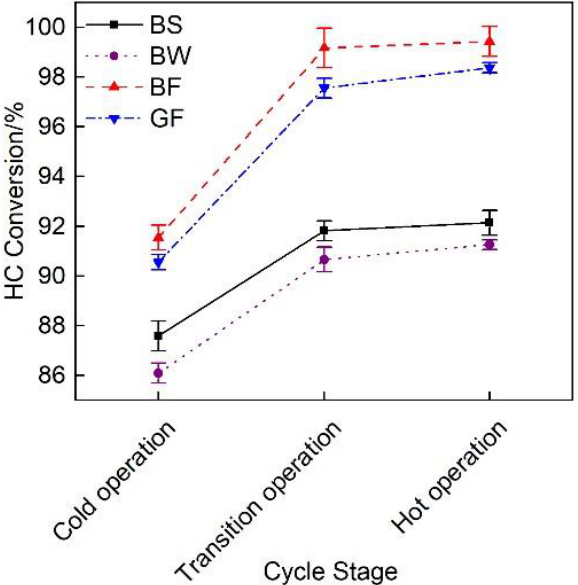
Figure 9. HC conversion rate of the different exhaust pipe covering schemes. Figure 10 shows the change curve of the particulate matter concentration of the exhaust pipes with the different covering schemes at each cycle stage. Under the effects of the DOC and DPF device combination, the particulate matter emissions of the different insulated pipes were relatively low and exhibited a trend of decreasing first and then slightly increasing. This occurred because at the beginning of the cycle, the exhaust temperature was low and the DOC performance was not high. During hot-state operation, a high exhaust temperature promoted the production of sulfate [31], thus causing a slight increase in particulate matter